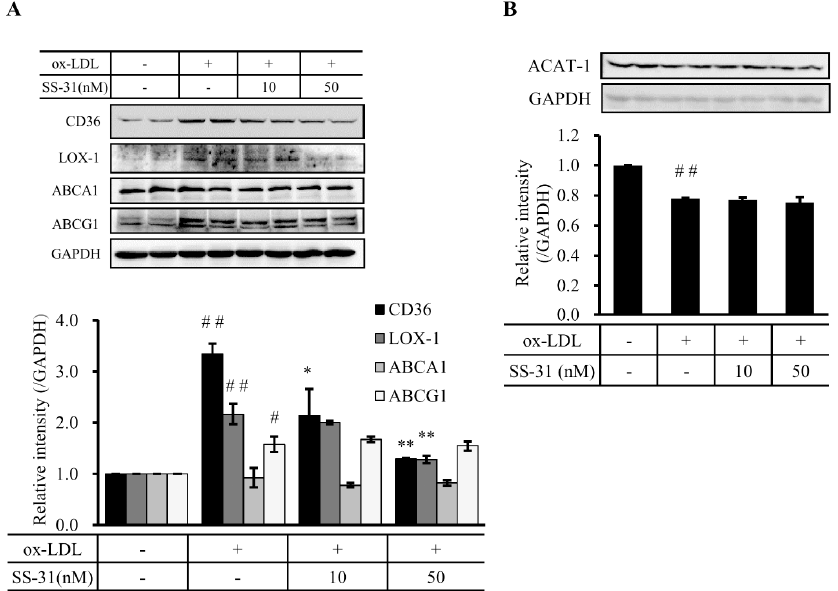
Figure 3. SS-31 down-regulates cholesterol influx in a dose dependent manner, but does not affect cholesterol efflux and endogenous cholesterol biosynthesis. ( A ) A representative western blot result (upper panel) and quantitative data (lower panel) of CD36, LOX-1, ABCA1, and ABCG1 protein levels after ox-LDL and/or SS-31 treatment of RAW264.7 cells; ( B ) A representative western blot result (upper panel) and quantitative data (lower panel) of the protein level of ACAT-1. GAPDH was used as a loading control. Cells were treated the same as in Figure 1. Results are from four independent experiments. # p < 0.05 and ## p < 0.01 compared with the control group, * p < 0.05 and ** p < 0.01 compared with the ox-LDL group.